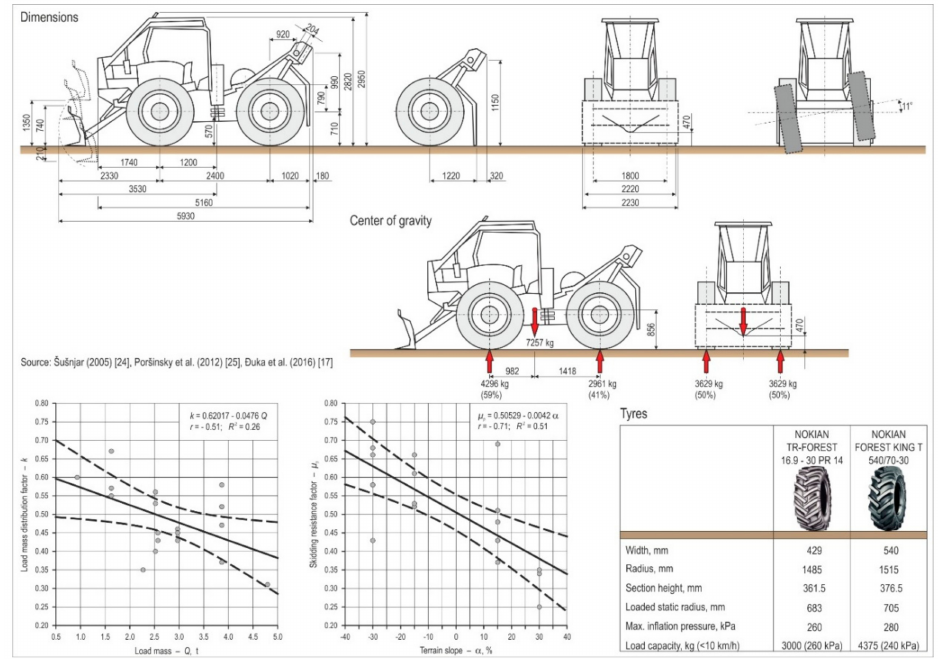
Figure 1. Skidder dimensions and tyre characteristics